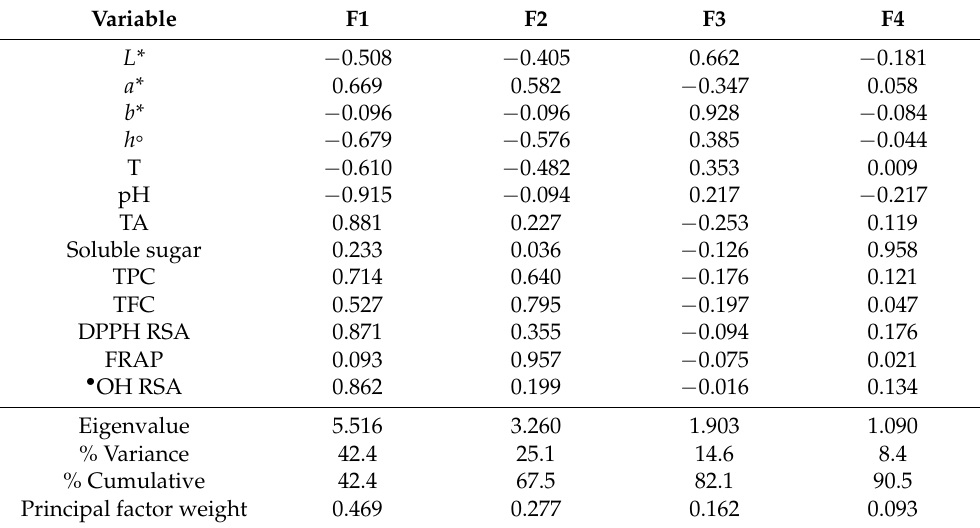
Table 5. Factor matrix including loadings, eigenvalues, percent of variance and cumulative variance for the first four principal factors.